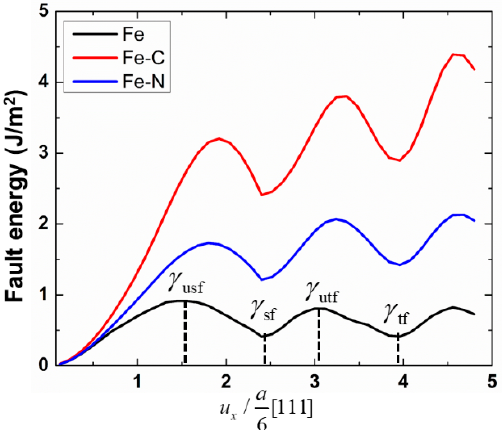
Figure A2. Generalized planer fault energy GPFE curves for Fe and Fe-C and Fe-N (N or C about 4% of all atoms).